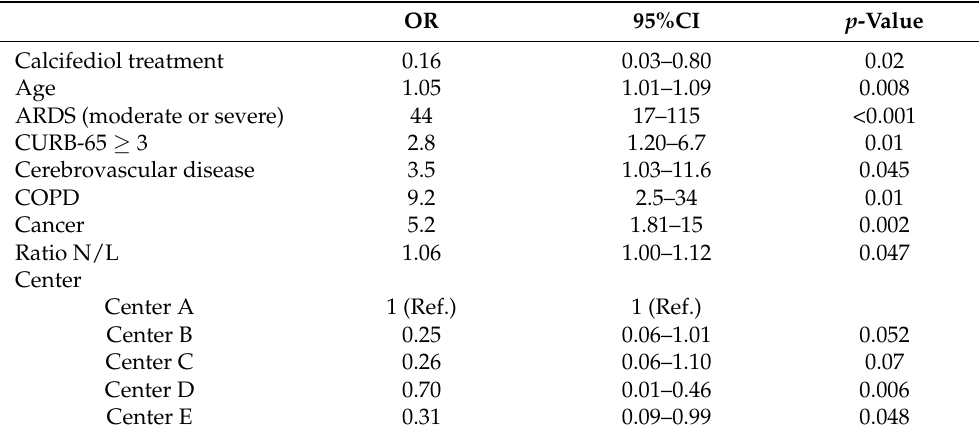
Table 2. Statistically significant variables of multivariable logistic regression model for risk of in-hospital death. OR 95%CI p